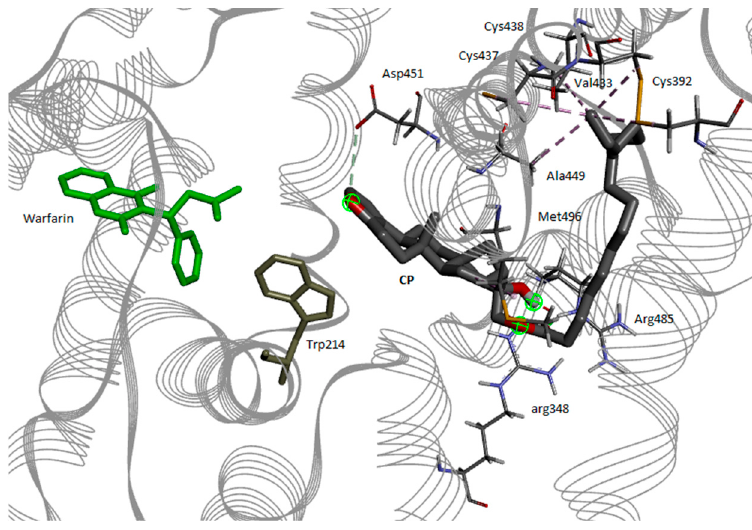
Figure 7. Best docking solution for cafestol palmitate (CP) inside FA4-Sudlow I sites.